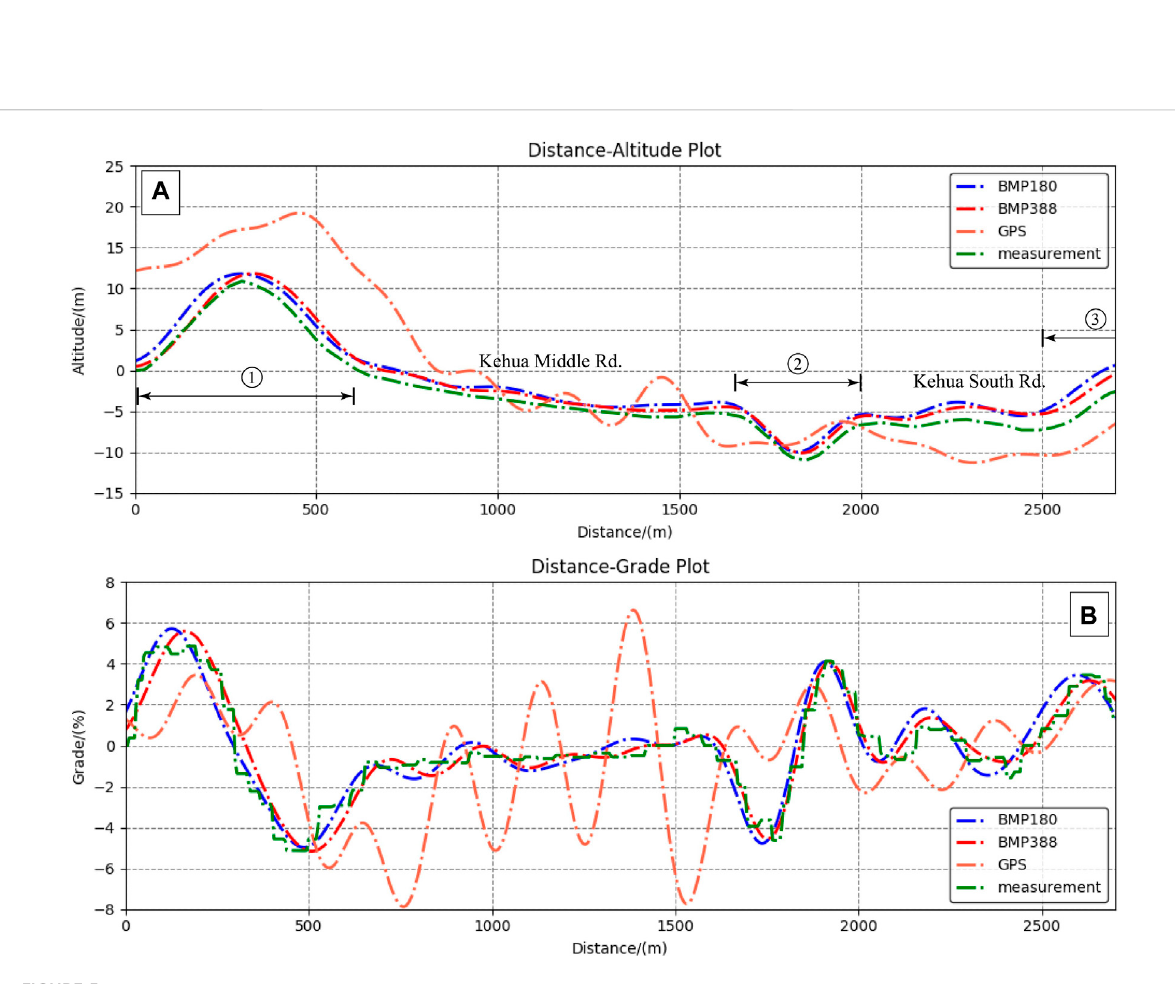
FIGURE 5 Altitude (A) and grade (B) variations of validation section based on different